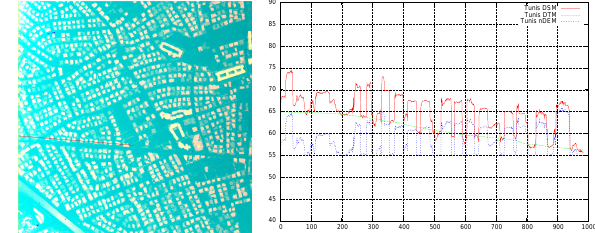
Figure 3: Left: Overlay of DSM (green), DTM (blue) and nDEM (red) of of Tunis area with depicted profile line (red); right: pro- files along profile line: DSM (red), DTM (green) and nDEM (blue) (heights in meter above WGS84 ellipsoid) structuring element: 2 px) gives the high objects from the nDEM (cf. Fig. 4, left). Combining the classification and these high ob- jects mask gives the classes buildings (high and non-vegetation), trees (high and vegetation), ground (all non high objects includ- ing water, vegetation and non-vegetation areas) as shown in Fig. 4, right.